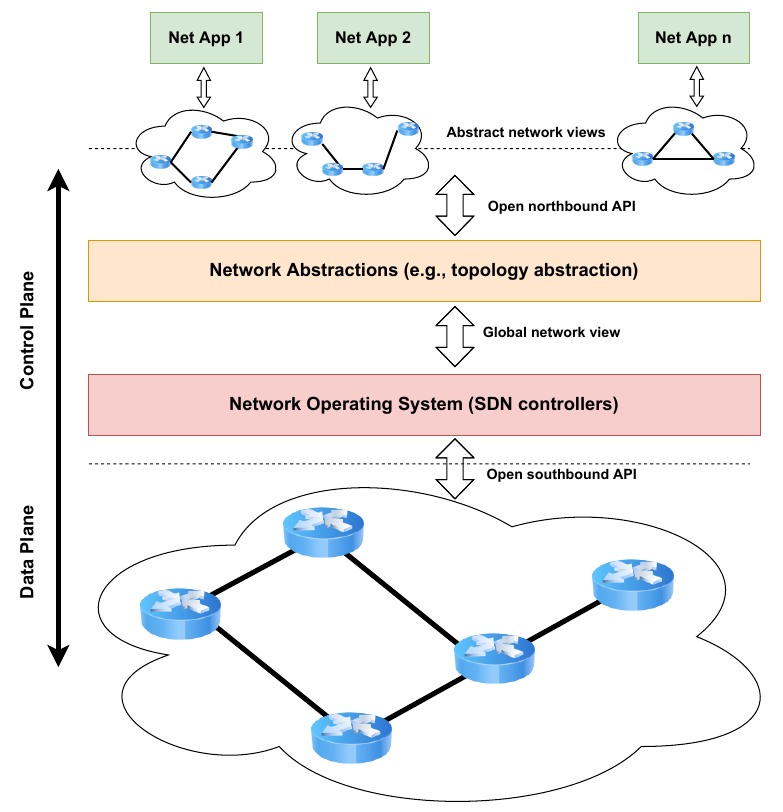
Figure 1. The SDN